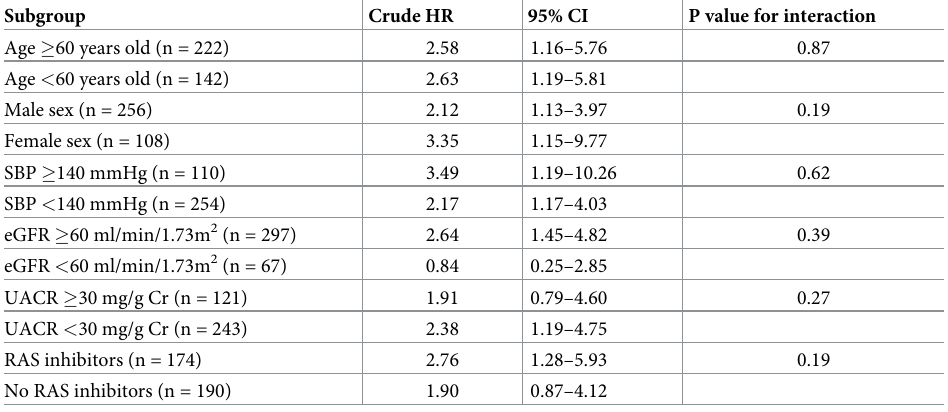
Table 3. Results of the association between sTNFR2 concentrations � 1.608 ng/mL and renal composite events stratified by age, sex, systolic blood pressure, eGFR, UACR, and the use of RAS inhibitors.